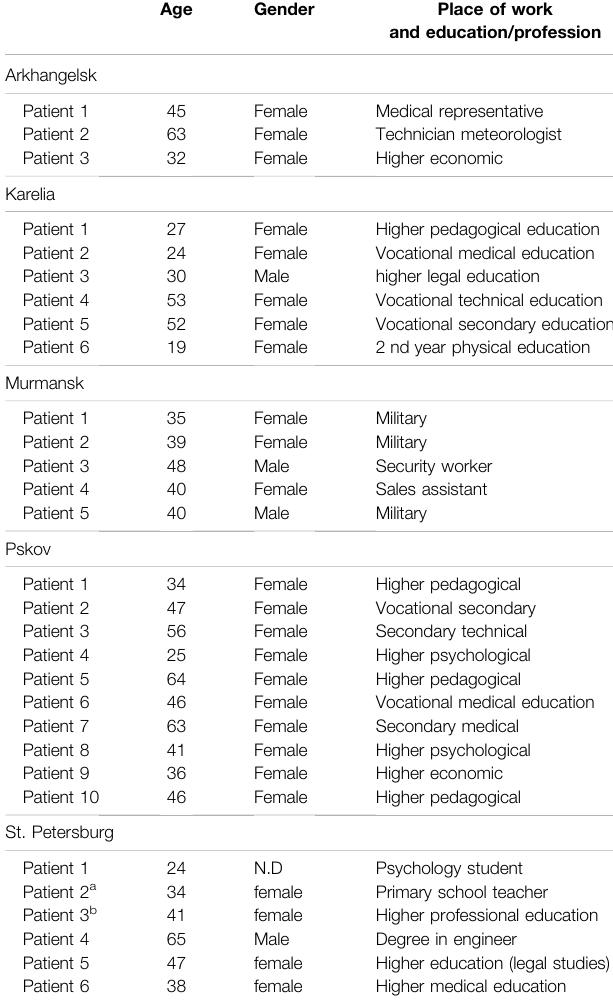
TABLE 3 | Overview of Patients without